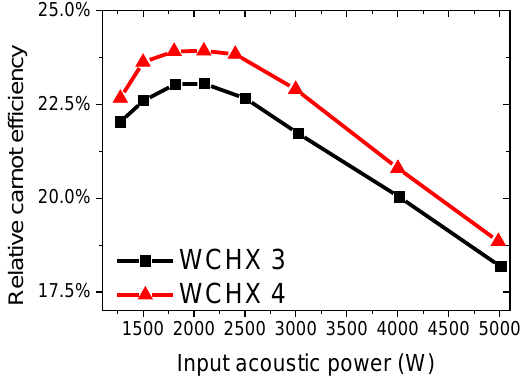
Figure 11. Dependence of relative Carnot efficiency on input acoustic power for WCHXs 3 and 4.